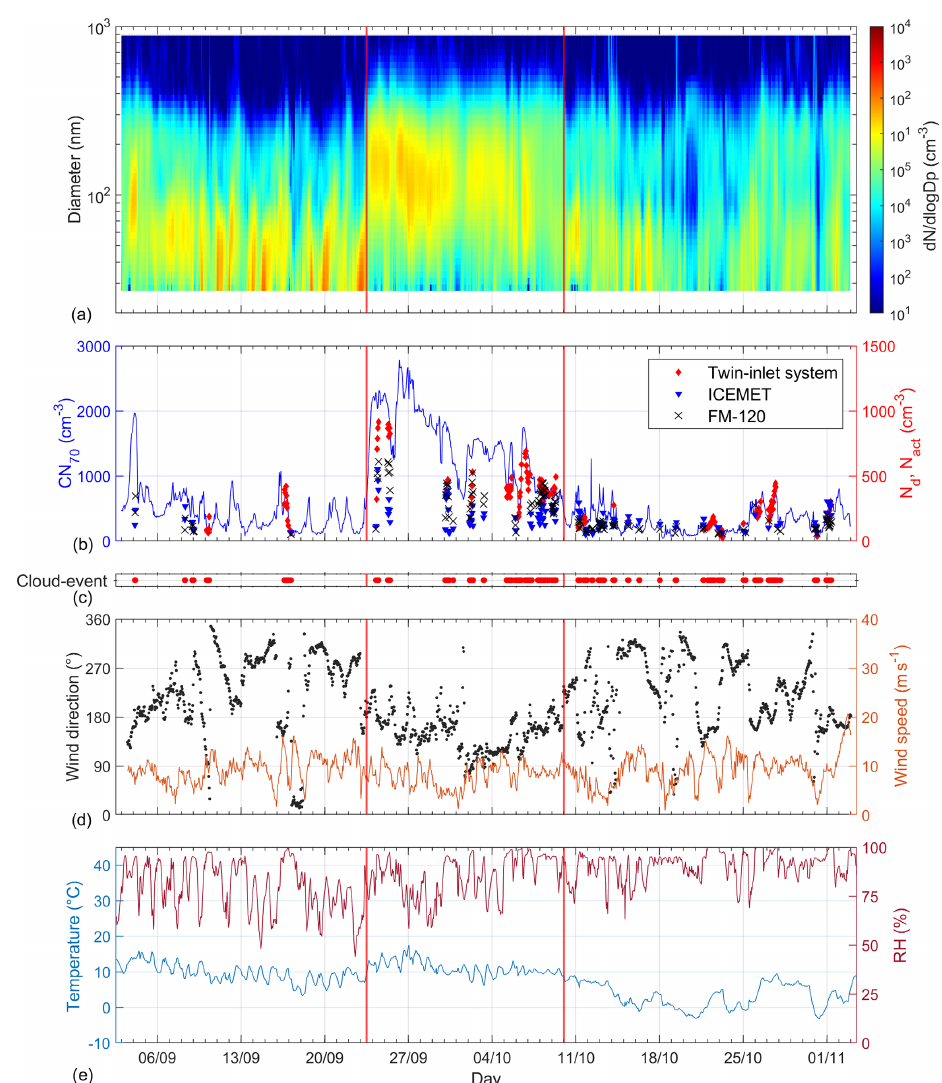
Figure 5. Variation of (a) particle size and concentration, and (b) concentrations of cloud condensation nuclei (CN 70 ), cloud droplets ( N d ), and activated particles ( N act ) in the period of intercomparison campaign from 3 September to 3 November 2020 at the Puijo measurement station. Observed cloud events (c) , the wind speed and directions (d) , and ambient temperature ( T ) and relative humidity (RH) (e) are also presented. The intensive smoke period is divided by red lines in panel (a)